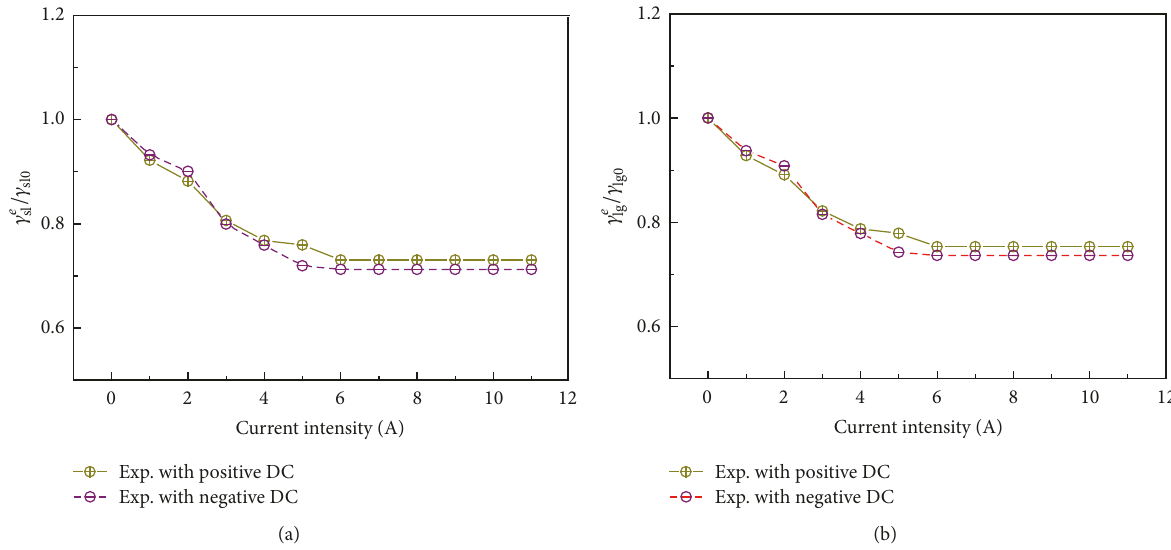
Figure 5: (a) Variation of solid-liquid interfacial tension ratio ( 𝛾 𝑒 tension ( 𝛾 𝑒 / 𝛾 ) with current intensity and polarity. lg 0 lg